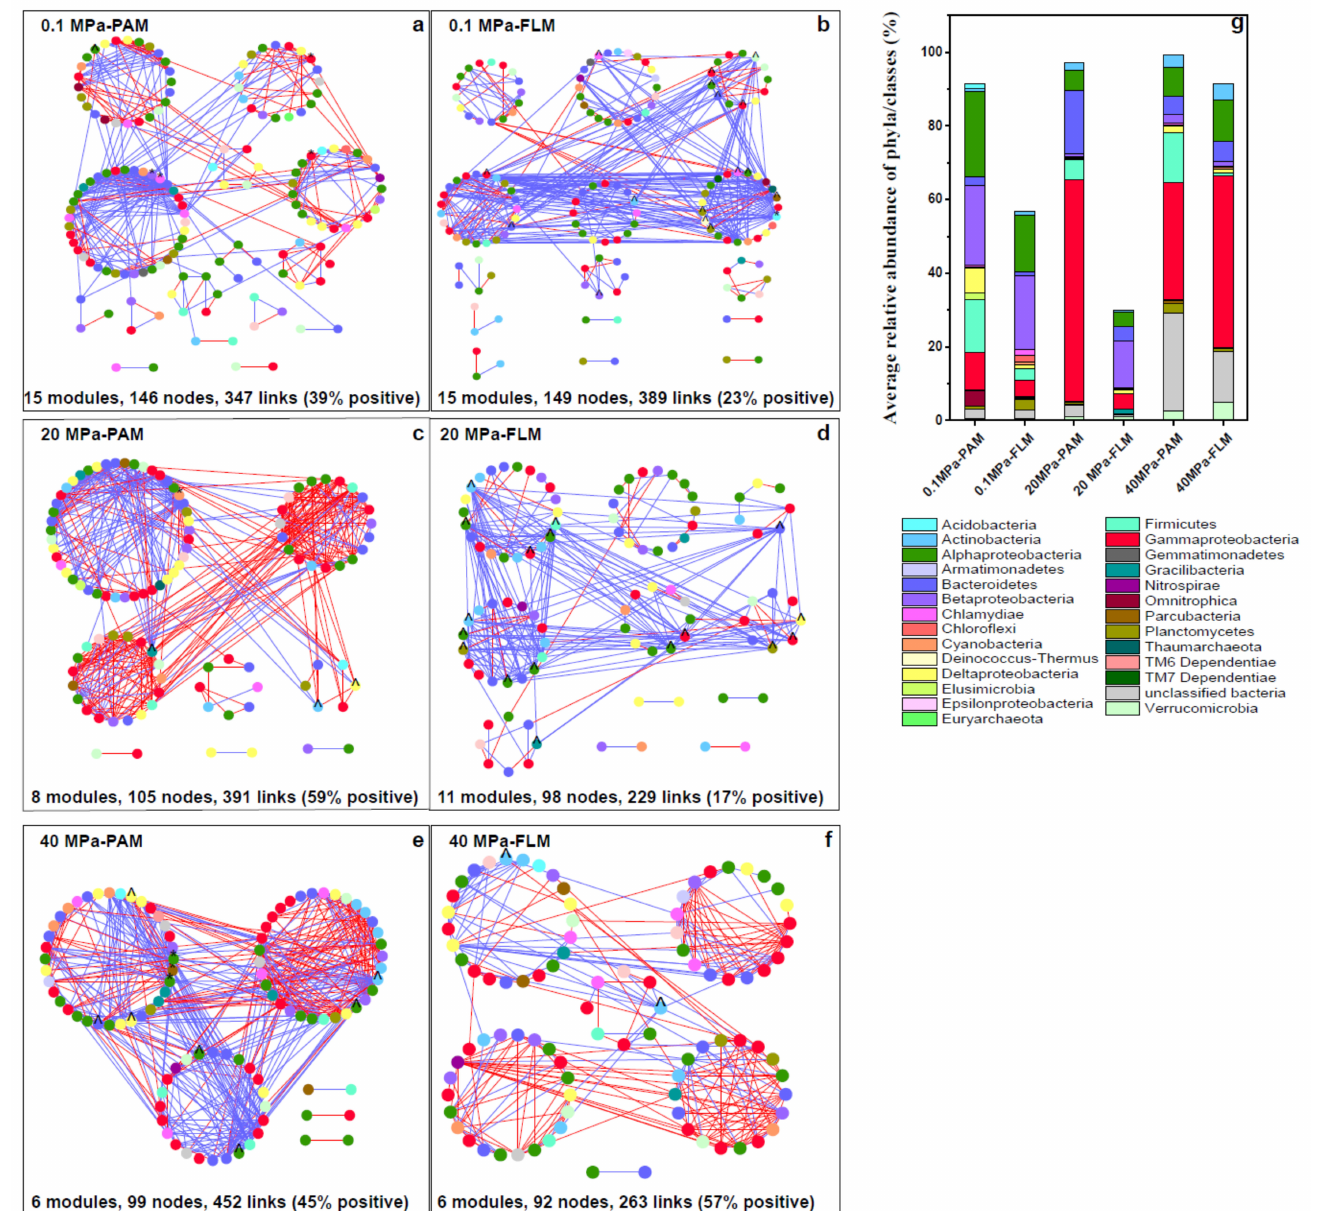
Figure 5. Network analysis of the particle-attached (PAM) and free-living microbial (FLM) com- munities during POM sinking at 0.1, 20, and 40 MPa, respectively. The networks were constructed using the MENA pipeline as described in Materials and Methods. Each node represents an OTU, and color of the nodes represents different phyla or classes of microorganisms. Each link represents either a positive (red line) or negative (blue line) correlation. Nodes with asterisk label (*) and label ˆ represent module hubs and connectors, respectively. ( a ) 0.1 MPa-PAM; ( b ) 0.1 MPa-FLM; ( c ) 20 MPa-PAM; ( d ) 20 MPa-FLM; ( e ) 40 MPa-PAM; ( f ) 40 MPa-FLM. ( g ) Average relative abun- dance of the PA or FL microbial taxonomic groups at phylum or class level under the three different pressures in the constructed